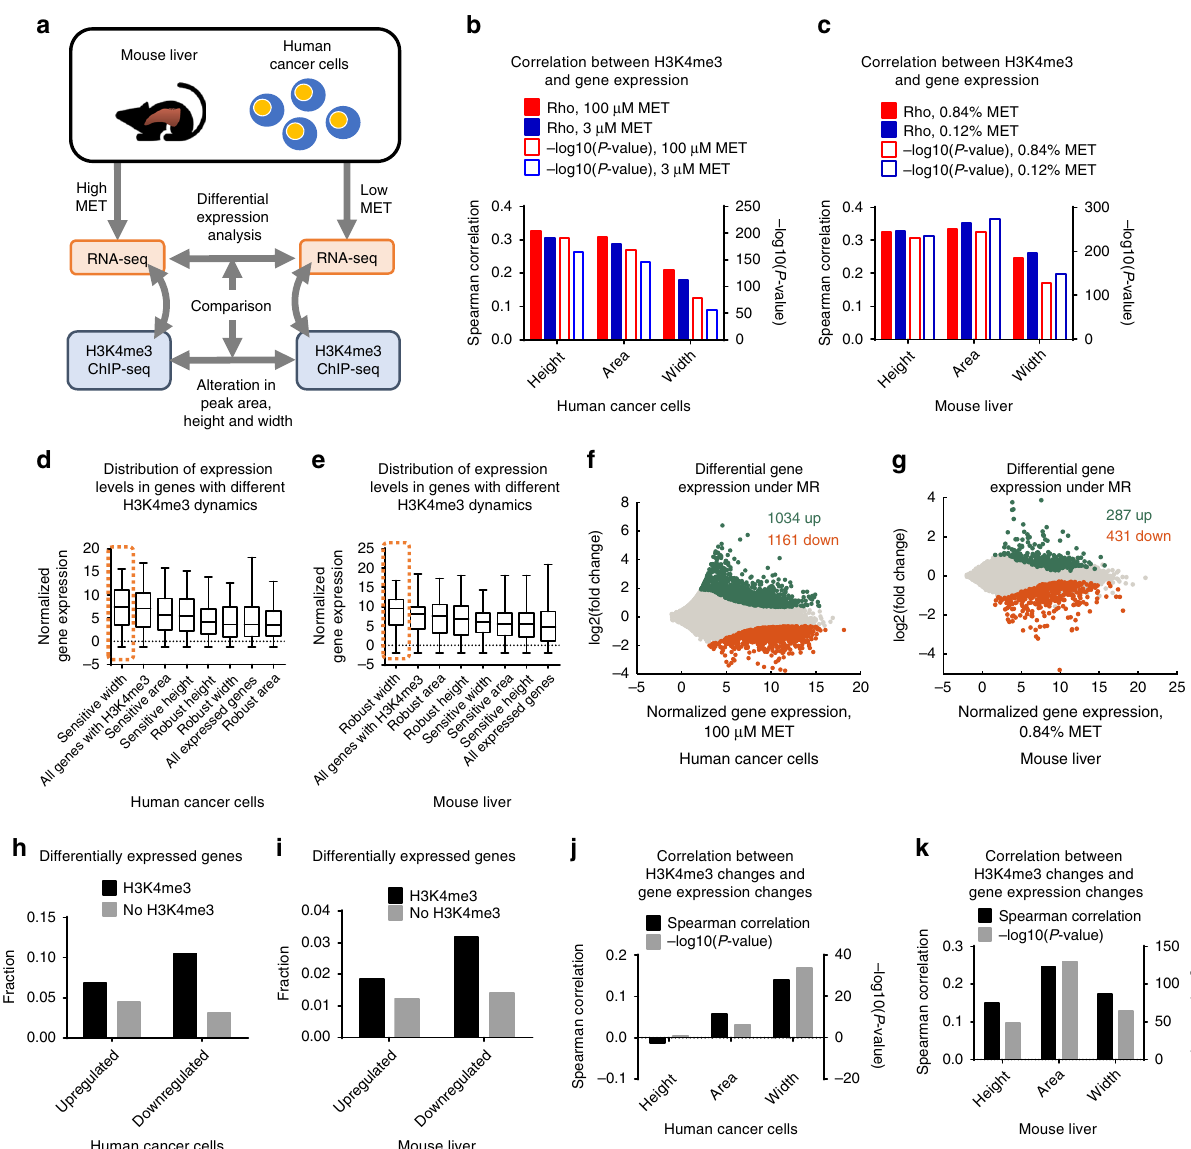
Fig. 4 H3K4me3 width dynamics predict differential gene expression. a Framework of RNA-seq data analysis. Mouse image used with permission from Microsoft. b Spearman correlation between peak size descriptors and gene expression levels in human cancer cells. c Same as in b but for mouse liver. d Expression levels of genes associated with different H3K4me3 dynamics under high methionine conditions in human cancer cells. The gene set with sensitive width which has been demonstrated to associate with cell type-speci fi c biological functions and TF binding is highlighted. Box limits are the 25th and 75th percentiles, center lines are medians, and the whiskers are the minimal and maximal values. e Same as in d but for mouse liver. f Differential gene expression in human cancer cells under MR. g Same as in f but for mouse liver. h Fraction of differentially expressed genes in genes with or without H3K4me3 in human cancer cells. i Same as in h but for mouse liver. j Spearman ’ s rank correlation coef fi cients between H3K4me3 changes and gene expression changes under MR in human cancer cells. k Same as in j but for mouse